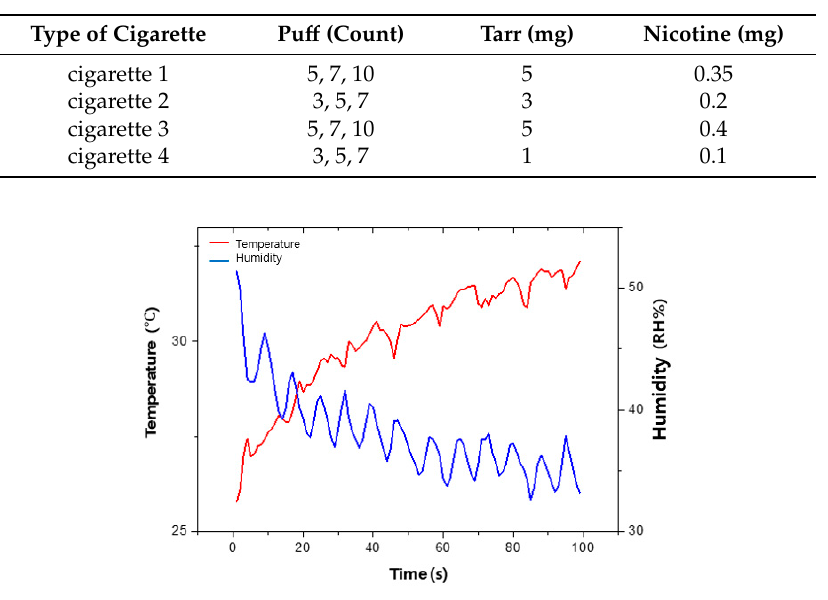
Figure 2. The experimental atmosphere: temperature and humidity changes.